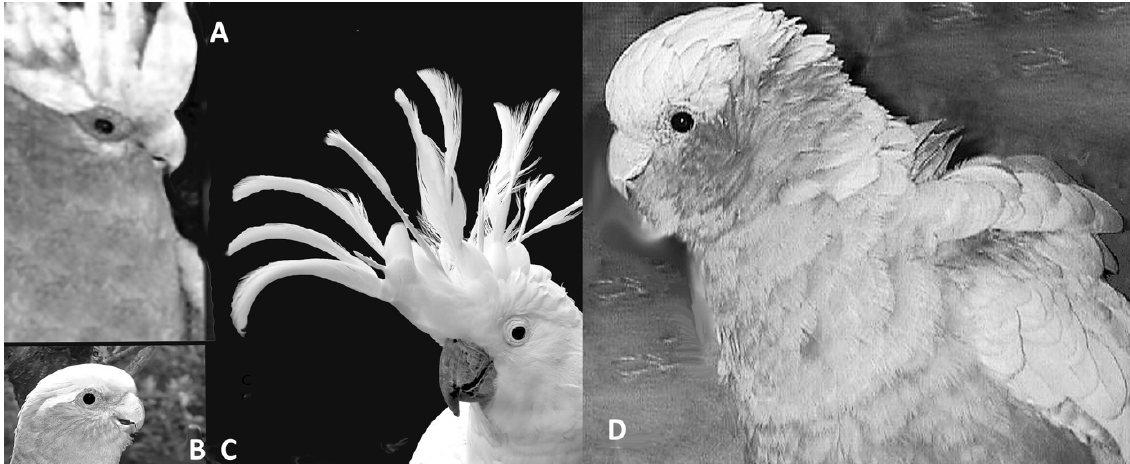
Figure 1. Expressing emotions via vocalizations, body posture, but also via feather positions. Among the easiest to ’read’ are the signals given by birds with crests. Crests can signal threat displays, curiosity, interest, play readiness, alarm, and many other emotions. All cockatoos have crests, including galahs. ( A ) A play face by an adult galah: wings out slightly and crest raised to full height. ( B ) Adult galah without crest erection, neutral but alert expression. ( C ) Adult sulphur-crested cockatoo alert but no sign of any animosity and ready to play or communicate. ( D ) Angry galah, back of the neck feather raising is common among many species but the addition of raising of breast feathers makes it abundantly clear to other galahs not to step any closer. Note that ( A , B , D ) are images taken by the author of the same bird in the same year. (Photo credit: G. Kaplan).